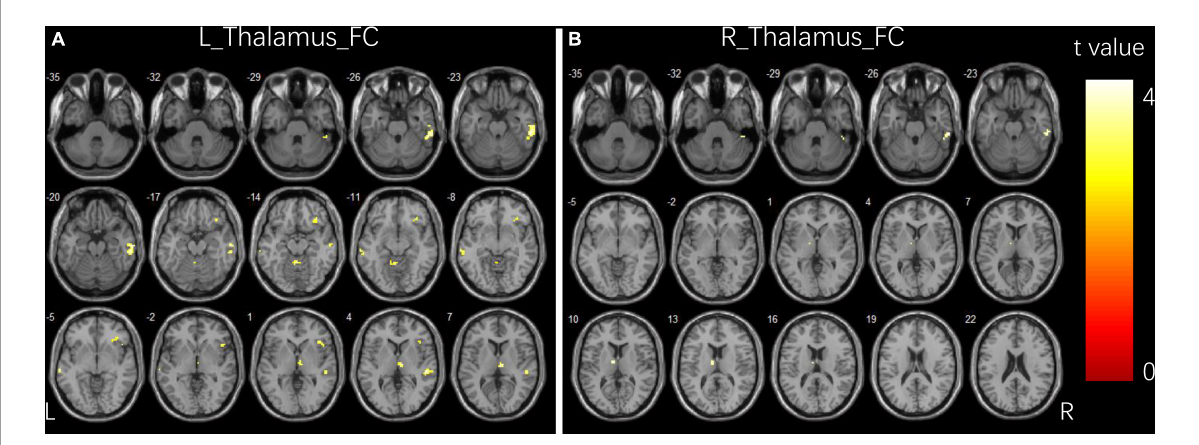
FIGURE1 Group differences in functional connectivity for bilateral thalamus seeds between two groups. (A) Brain regions showing significant differences in FC for left thalamus seed. (B) Brain regions showing significant differences in FC for right thalamus seed. The comparison analysis was thresholded at p < 0.005, AlphaSim corrected. R, right hemisphere; L, left hemisphere; FC, functional connectivity.